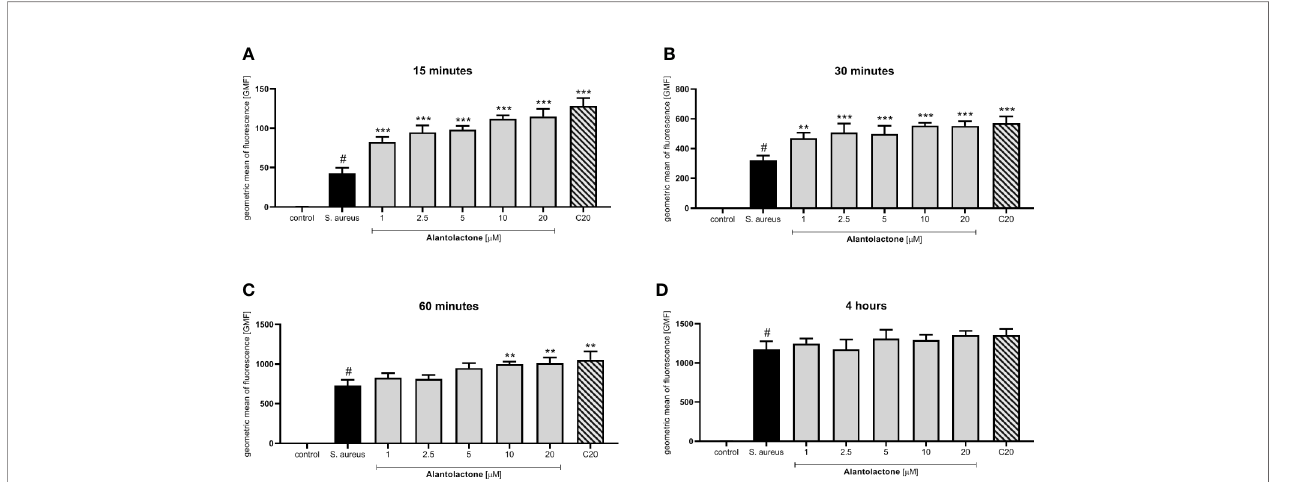
FIGURE 2 | The in fl uence of alantolactone treatment on S. aureus uptake by THP-1 cells. Data show geometric mean of fl uorescence (GMF) phagocytosed heat-killed S. aureus by THP-1 cells at different time-points: (A) 15 min after infection, (B) 30 min after infection, (C) 60 min after infection and (D) 4 hours after infection. Each experimental set was compared to S. aureus -stimulated control.Statistical signi fi cance: *p < 0.05, **p < 0.01, ***p < 0.001 versus stimulated control, # statistically signi fi cant (p < 0.001) versus non-stimulated control (ANOVA and Dunnett ’ s post hoc test); control-non-stimulated control; S. aureus - S.aureus -stimulated